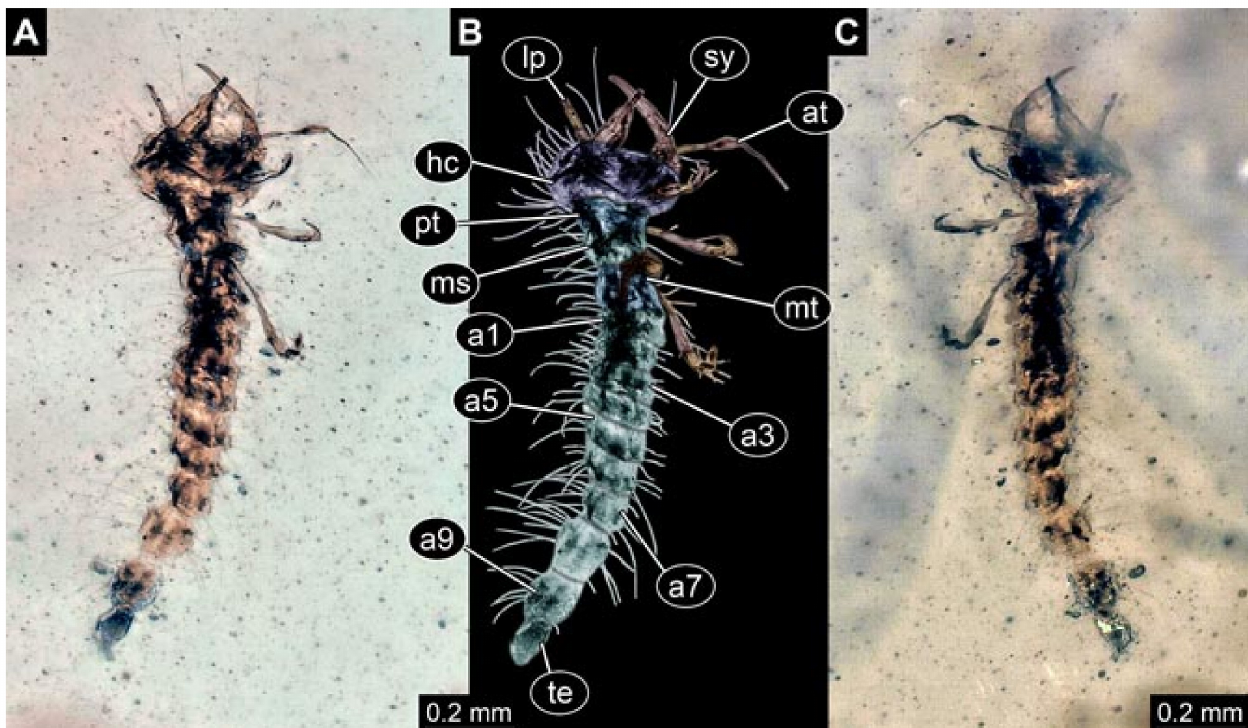
Figure 24. Specimen 5855 (PED 0898); Myanmar amber. ( A ) Dorsal view. ( B ) Dorsal view, colour-marked. ( C ) Ventral view. Abbreviations: a1–a9 = abdomen segments 1–9; at = antenna; hc = head capsule; lp = labial palp; ms = mesothorax; mt = metathorax; pt = prothorax; sy = stylet; te = trunk